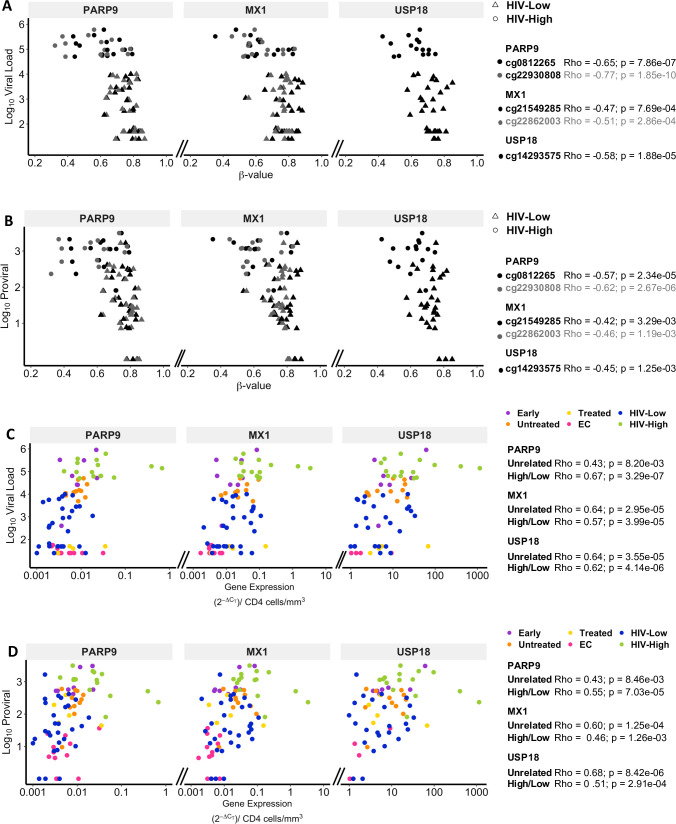
Correlations of gene expression and methylation levels of PARP9, MX1 and USP18 with HIV viral load and proviral.(A and B) PARP9, MX1 and USP18 correlation of methylation levels (X-axis) and HIV plasma viral load (A, Y-axis) or HIV proviral levels at PBMCs (B, Y-axis) in HIV-High and HIV-Low individuals. The different CpG positions are in different color (black and grey) and the two studied groups HIV-High and HIV-Low are indicated with a triangle and a square, respectively. (C and D) Correlation of PARP9, MX1 and USP18 gene expression determined by qRT-PCR and HIV plasma viral load (C, Y-axis) or HIV proviral levels at PBMCs (D, Y-axis). The different colors indicate the different groups of individuals including those in unrelated cohorts (Early in purple, Untreated in orange, Treated in yellow, EC in red) and HIV-High (green) and HIV-Low (blue). Spearman’s rank correlation test was applied for correlation analysis. In all cases, p-values <0.05 were considered significant.